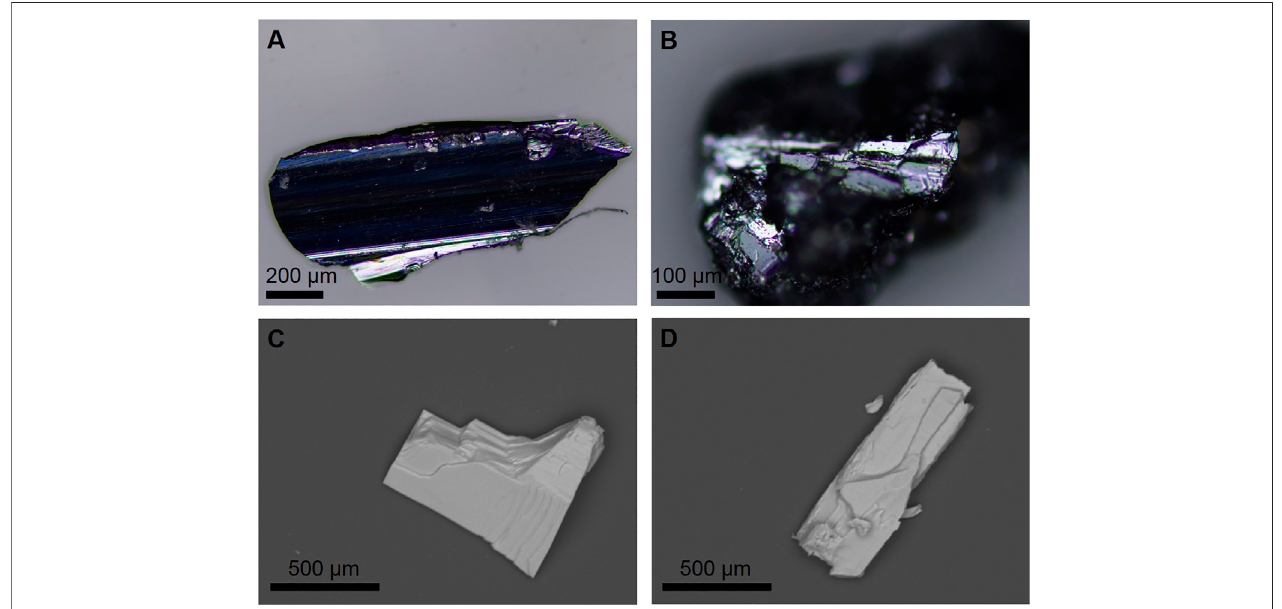
FIGURE 3 | Optical images of as-grown InSe crystal (A) and In 2 Se 3 crystal (B) . SEM image of InSe crystal (C) and In 2 Se 3 crystal (D) exfoliated on SiO 2 substrate. SEM, scanning electron microscopy.